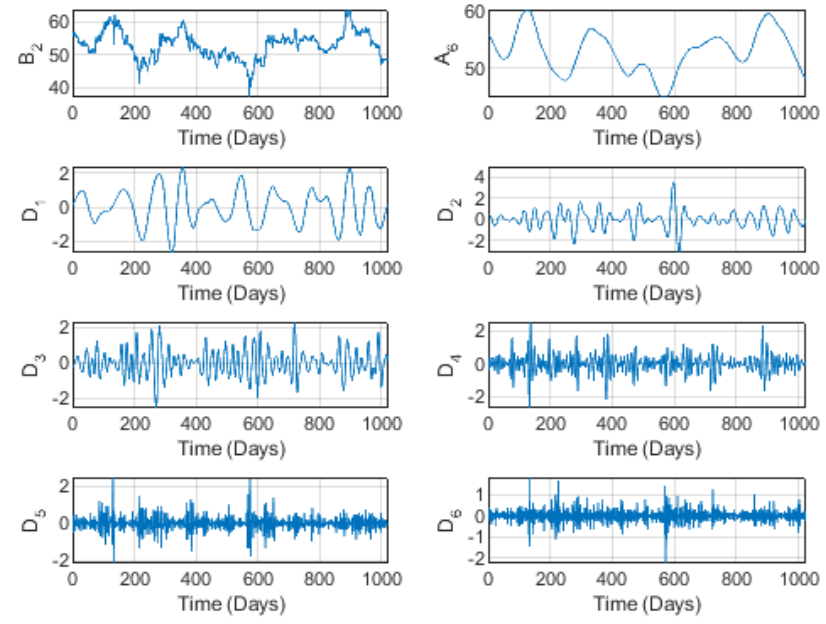
Figure 3. The wavelet decomposition of the Almarai brand B 2 prices at level 6.